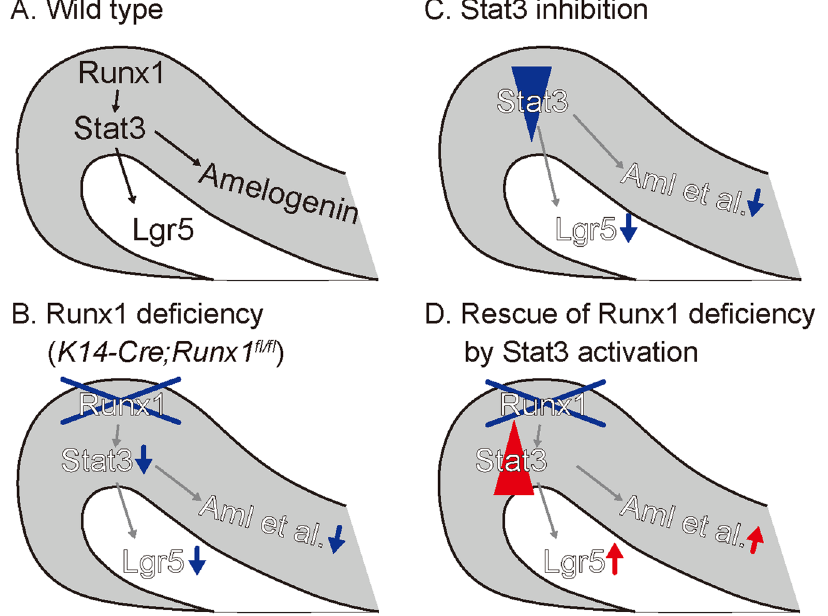
Figure 6. A schematic illustration of the key findings of this article. ( A ) In the cervical loop of the wild type incisors, Runx1 regulates Stat3 phosphorylation, which further regulates the expression of Lgr5 and enamel matrix protein. ( B ) In the Runx1 mutant incisors, Stat3 phosphorylation was significantly disturbed with the downregulated expression of Lgr5 and enamel matrix proteins. ( C ) The pharmaceutical Inhibition of Stat3 signaling resulted in the significant downregulation of Lgr5 and enamel matrix proteins. ( D ) Pharmaceutical Stat3 activation upregulated the expression Lgr5 and enamel matrix proteins in Runx1